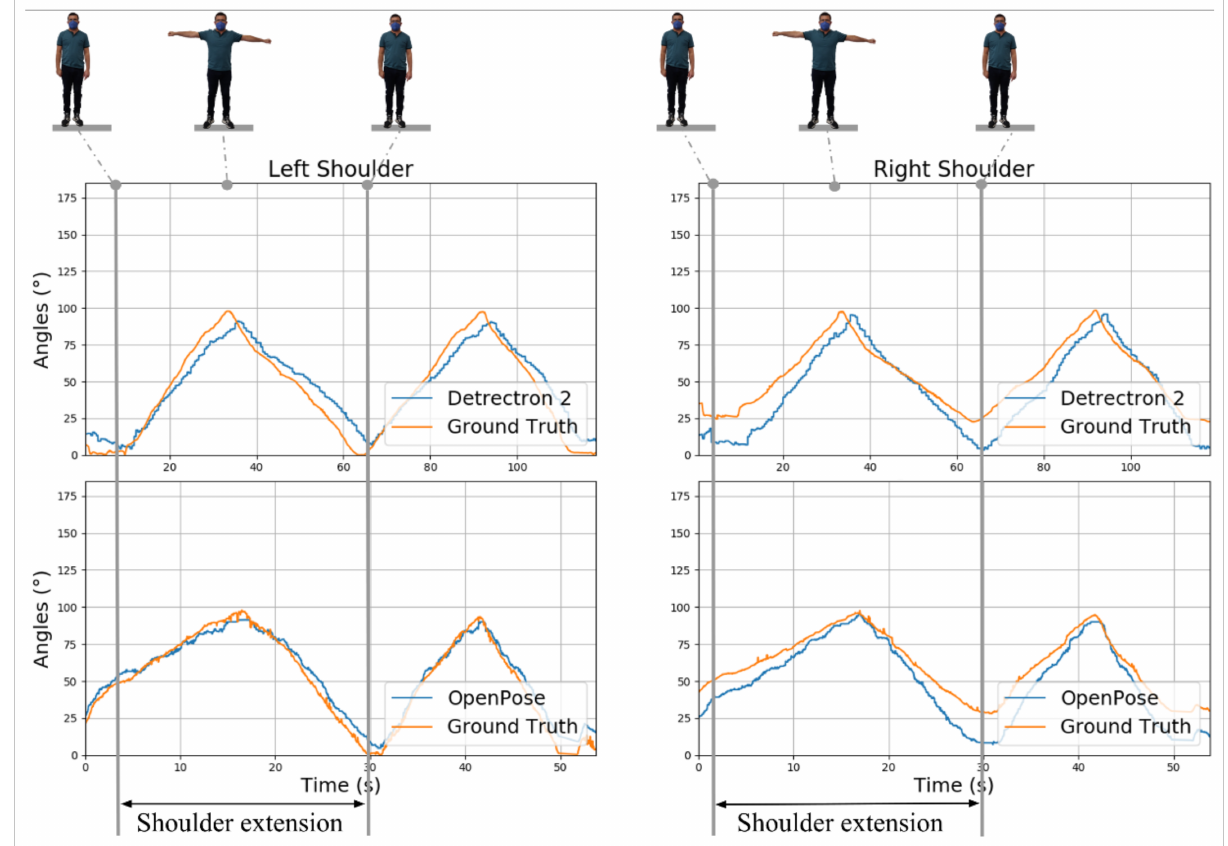
Figure 8. Exercise 3: angles of both shoulders in extension rehabilitation exercise for two